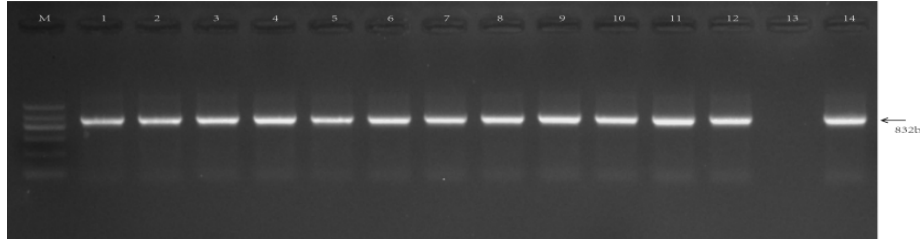
Figure 6. PCR analysis of hpt in different transgenic rice. M: M5 Marker II DNA Marker, 1–2: GSX7R- 2097; 3–4: GSX7R-1765, 5–6: GSX7R-1198, 7–8: GSX7R-554, 9–10: GSX7R-1543, 11–12: GSX7R-1212, 13: non-transgenic rice, 14: Positive plasmid control.